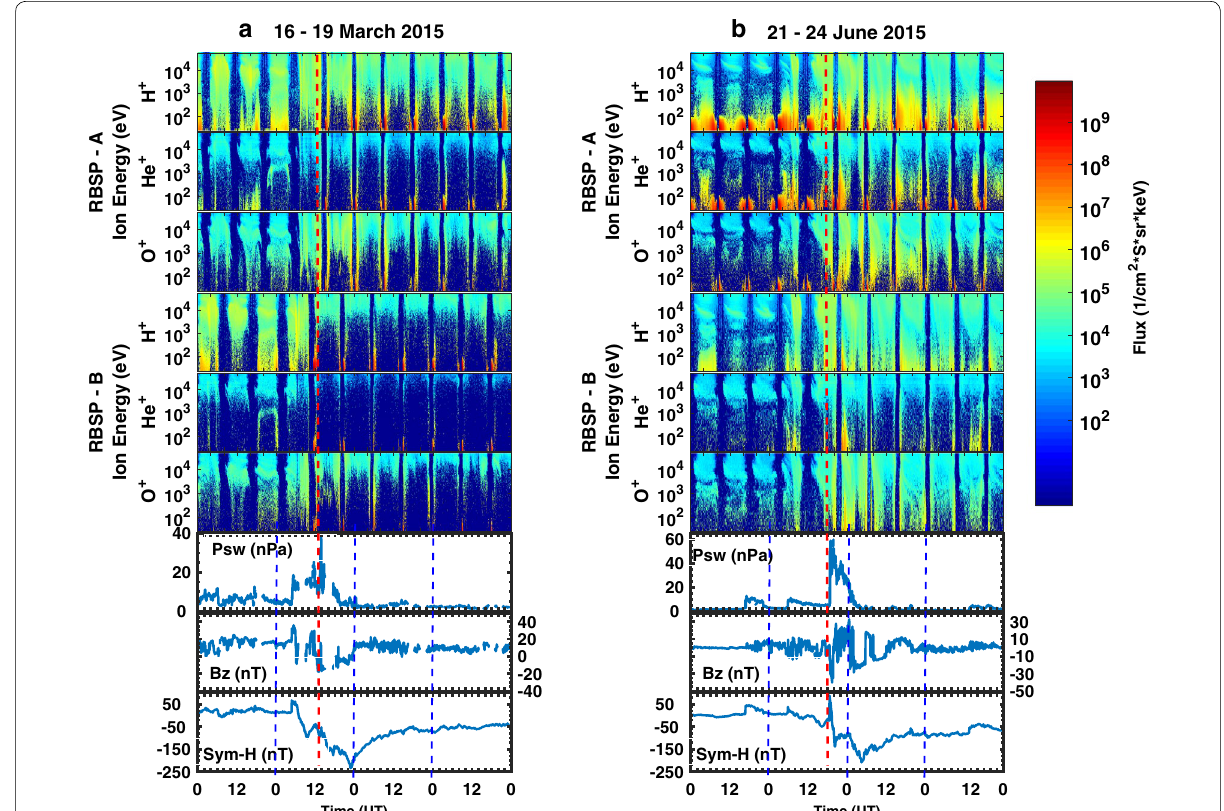
Fig. 6 Energy-time spectra for H + , O + and He + from RBSP-A (top three panels), RBSP-B (middle three panels) and plots in the lower three panels are solar wind dynamic pressure, IMF Bz and Sym-H for a 16–19 March 2015 b 21–24 June 2015. Black vertical line shows the time of SSC while the blue vertical lines correspond to each day